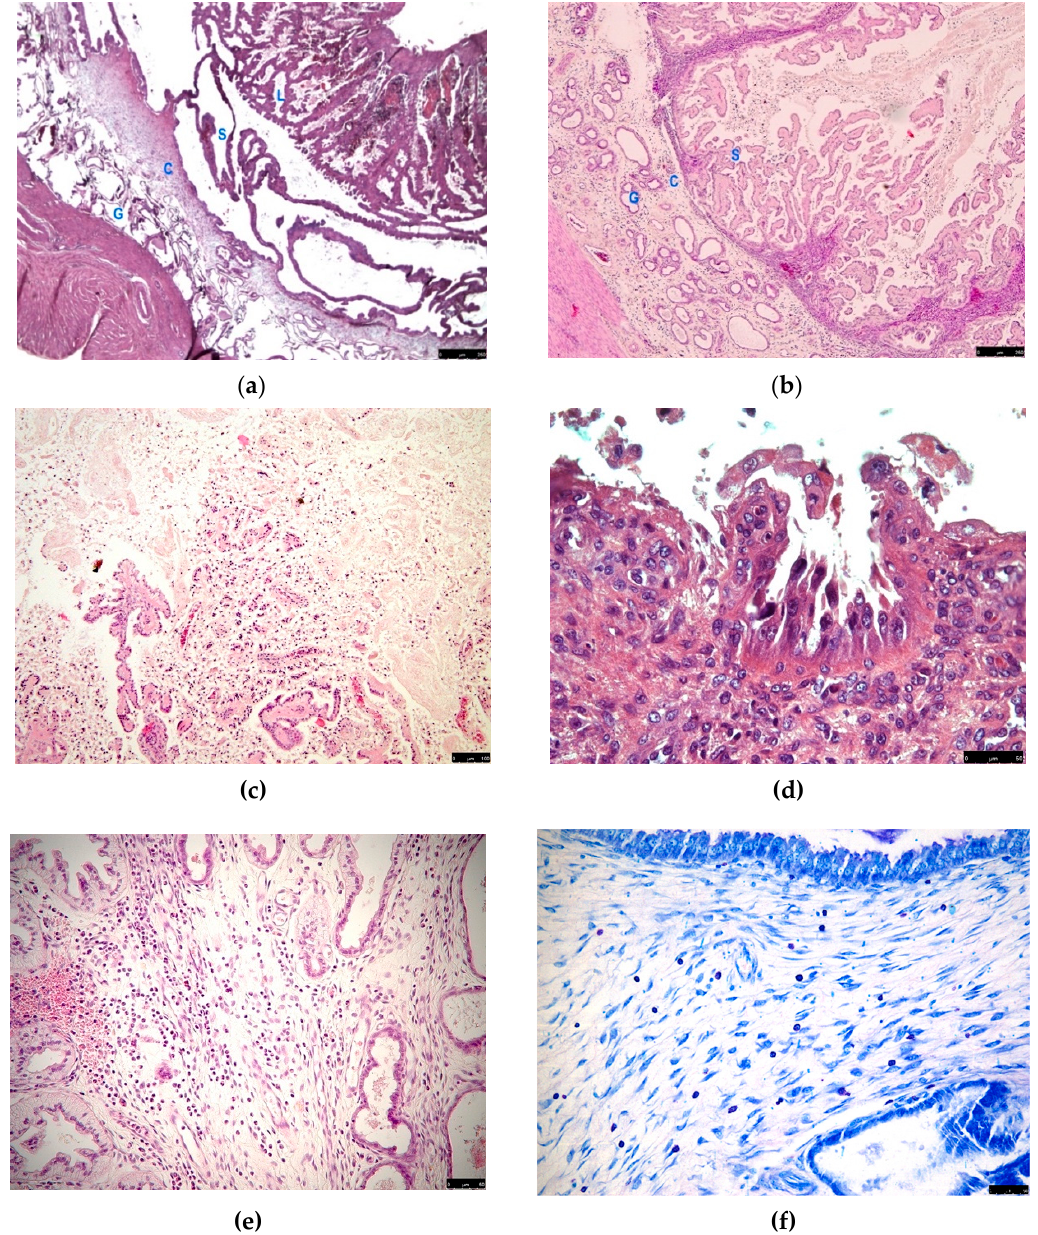
Figure 3. Histological findings in cases of pseudo-placentational endometrial hyperplasia: ( a ) the complete architecture of the lesion (D1) with 4 layers (G = glandular, C = connective, S = spongy, L = labyrinth), haematoxylin-eosin, bar = 250 μ m; ( b ) the lesion (D2) with labyrinth zone degenerated, haematoxylin-eosin, bar = 250 μ m; ( c ) case D5 dissolution of the inner layer for coagulative necrosis, haematoxylin-eosin, bar = 100 μ m; ( d ) case D6, exfoliation of foamy cells in the inner layer, haematoxylin-eosin, bar = 50 μ m; ( e ) inflammatory infiltrates in case D2, haematoxylin-eosin, bar = 50 μ m; ( f ) numerous mast cells showing metachromasia in the connective layer of case D1, Giemsa stain, bar = 50 μ m.